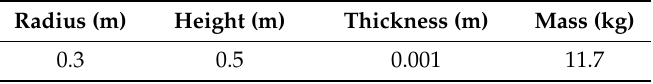
Table 3. The dimensions and mass of the buoy.